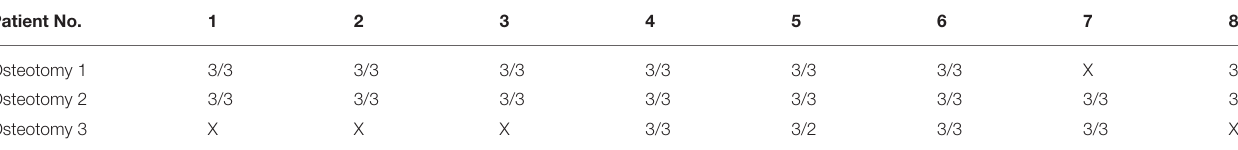
TABLE 3 | Qualitative analysis of osseous union (1 = non-union, 2 = partial-union, 3 = union). Patient No.